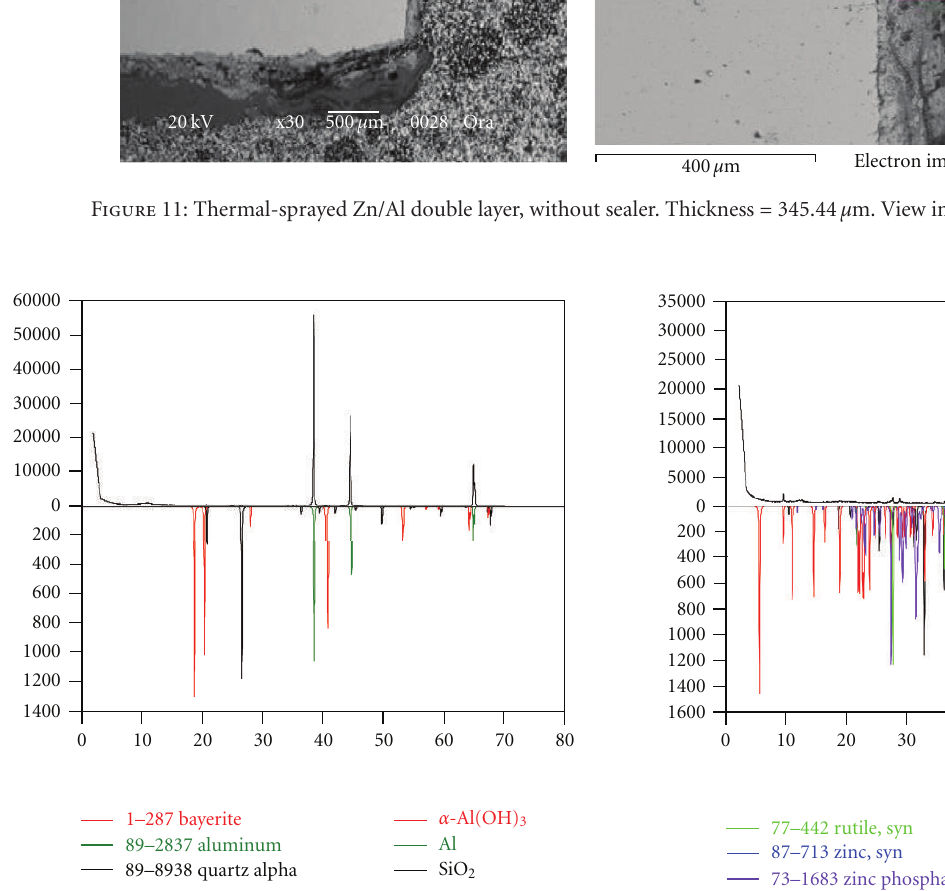
Figure 12: Spectrum of the double-layer system without sealer.